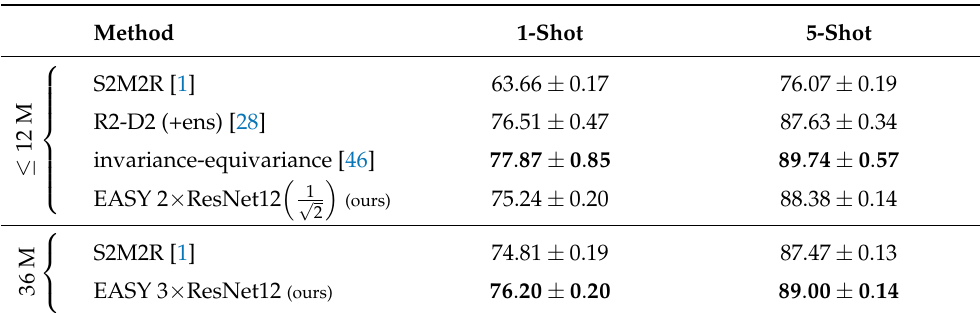
Table 3. The 1-shot and 5-shot accuracy of state-of-the-art methods and the proposed solution on CIFAR-FS in the inductive setting.